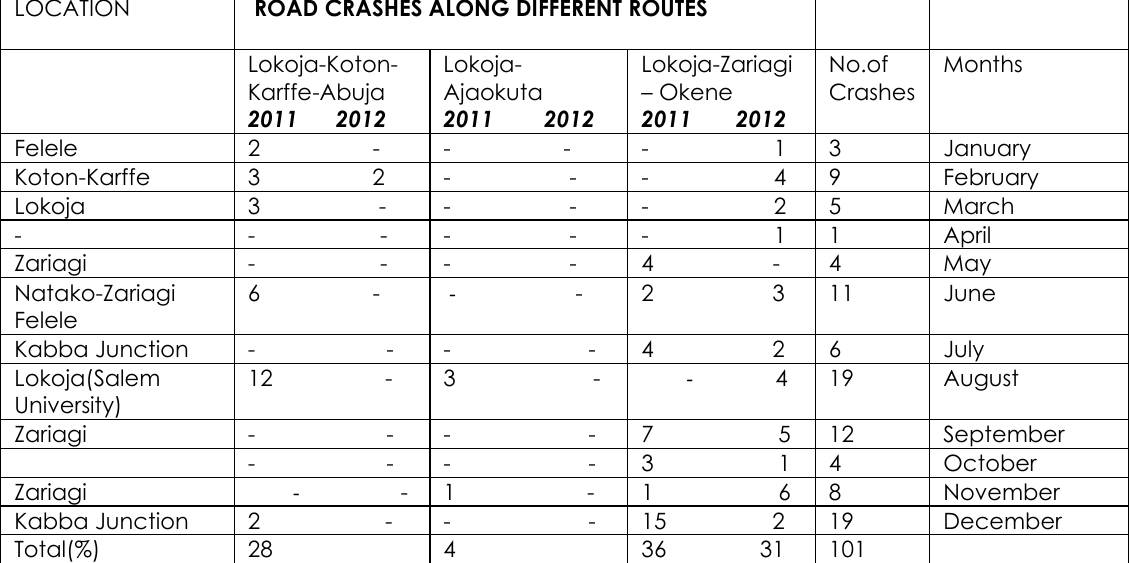
Table 7: Children Involved in Road Traffic Crashes across Different Routes Segments in Lokoja Metropolis 2011-212 LOCATION